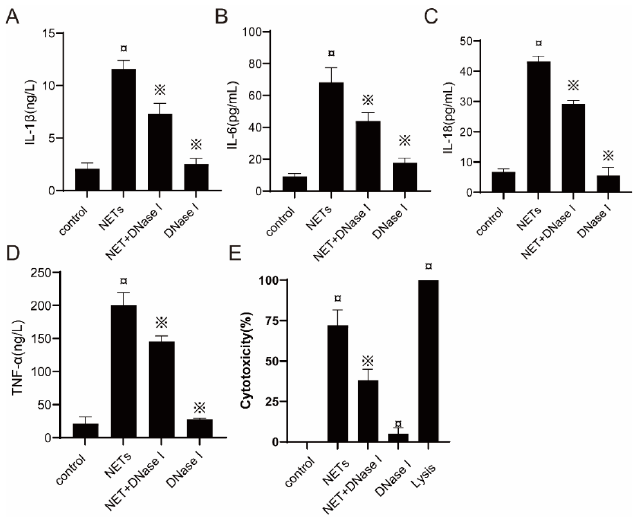
Figure 6. Cytokine production and cytotoxicity of untreated bovine endometrial epithelial cells (BEECs) (control), NET-treated BEECs (NET), NET- and DNase I-treated BEECs (NET+ DNase I), and DNase I-treated BEECs (DNase I). The BEECs were incubated with NETs or DNase I for 16 h. The levels of ( A ) IL- 1β, ( B ) IL-6, ( C ) IL-18, and ( D ) TNF- α in BEEC supernatants were detected by ELISA. ( E ) The cytotoxicity of BEECs was determined after treatment with NET (500 ng/mL), NET (500 ng/mL) + DNase I (25 µg/mL), or DNase I (25 µg/mL) for 16 h. Lysis provided by LDH cytotox- icity assay kits was used as a positive control. Values are presented as the mean ± SD ( n = 3). ¤ p < 0.05 vs. control group and ※ p < 0.05 vs. NETs without DNase I.